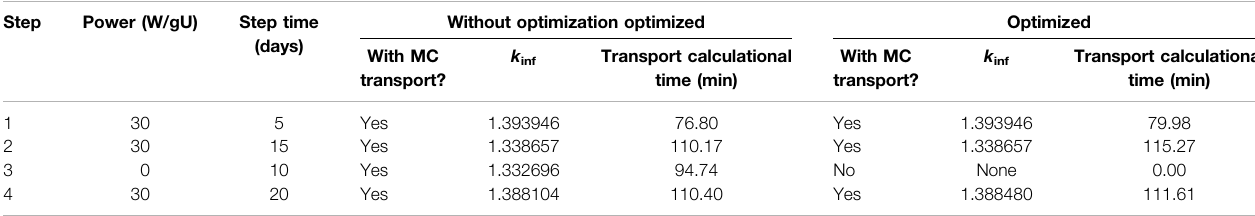
TABLE 4 | K-eigenvalues and wall-clock times for the various burnup